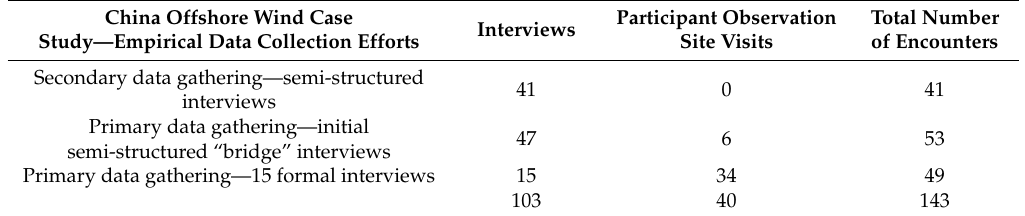
Table 1. Summary of all encounters of the China offshore wind case study included in this research.